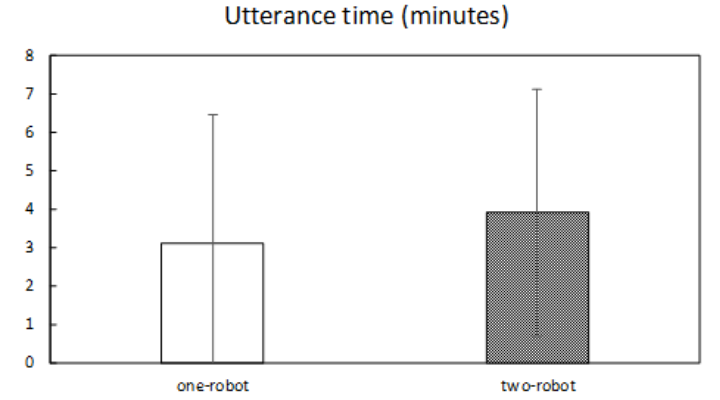
Figure 9. Averages of the user utterance time in each scenario.